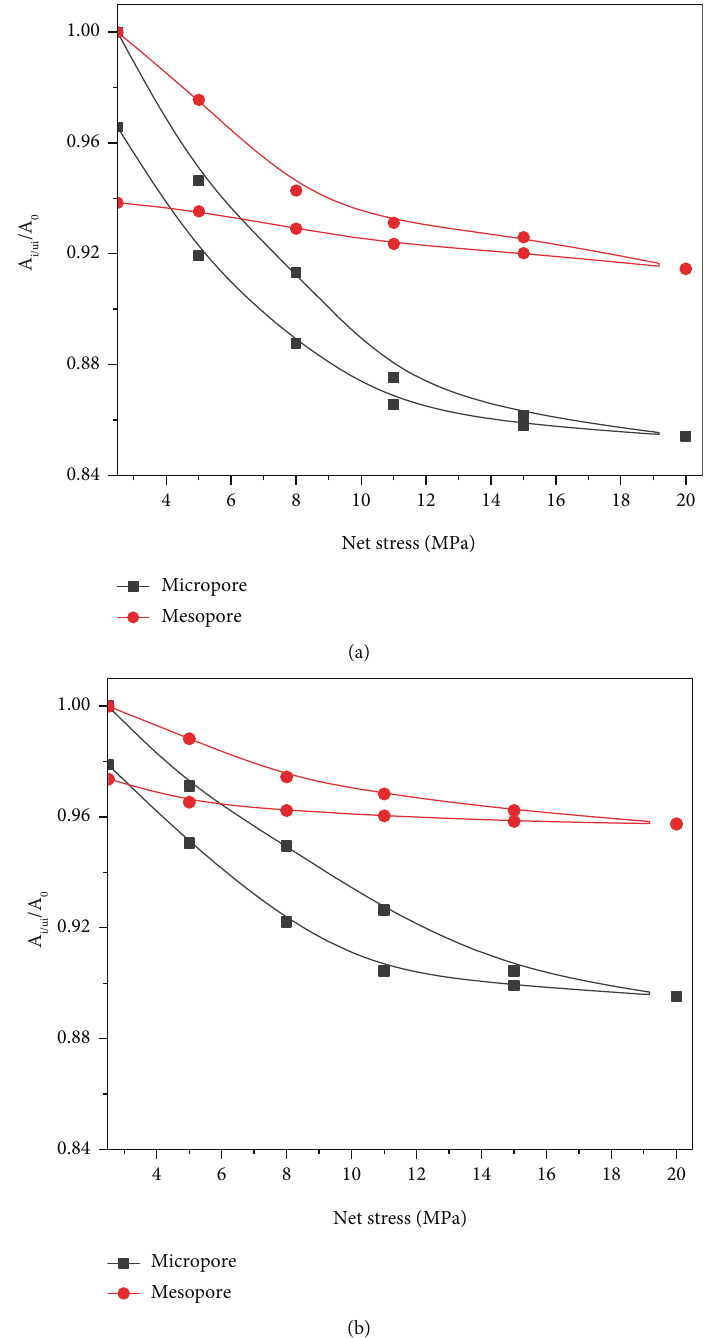
Figure 7: The relation between pore volume and the net stress: (a) variable con fi ning pressure, (b) variable fl ow